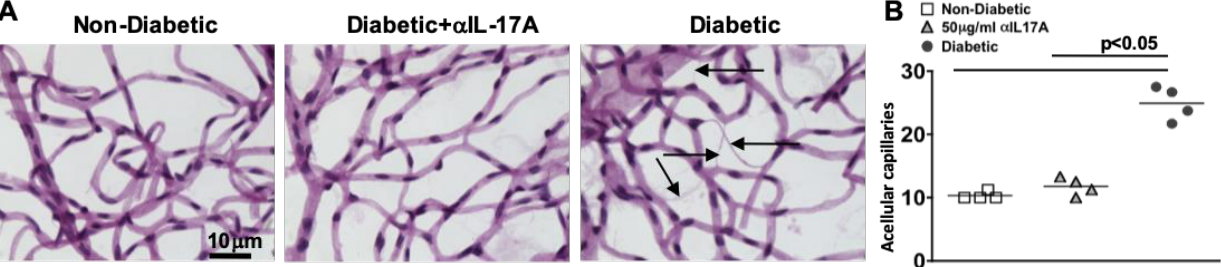
Figure 8. Retinal Capillary Degeneration in anti-IL-17A Treated db/db Mice. ( A ) Representative images of acellular capillaries (highlighted by black arrows) in retinal capillary beds of non-diabetic, anti-IL-17A treated diabetic, and untreated db/db diabetic mice (scale bars of all images = 10 μ m. ( B ) Quantification of acellular capillaries in each retina of non-diabetic, anti-IL-17A treated diabetic, and untreated diabetic mice; 6 months post-diabetes. Each data point represents an individual retina. Error bars represent the SEM. All p -values were first equated using 2-way ANOVA and then unpaired student’s t - test with Tukey’s post -hoc analysis.